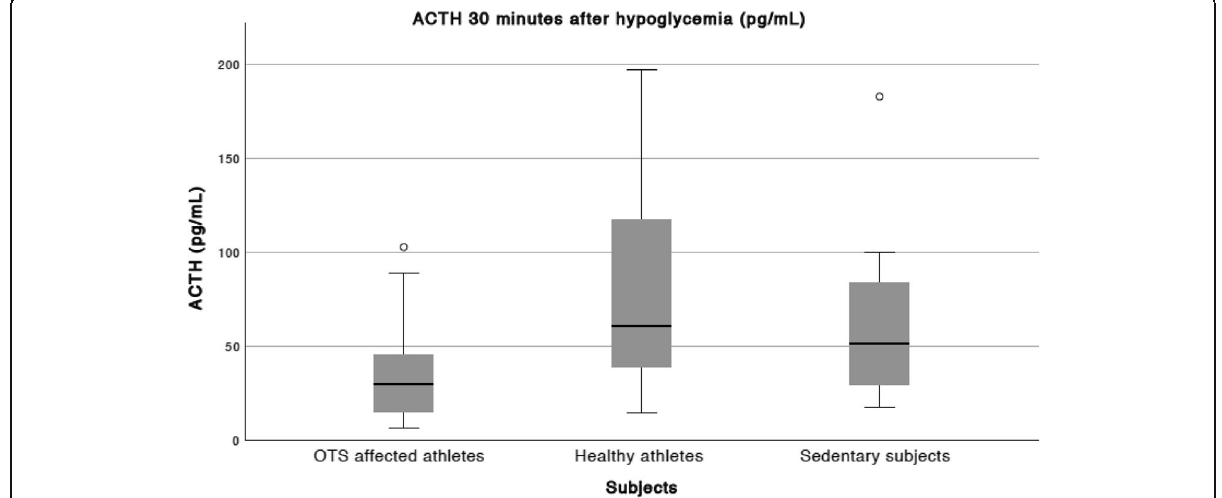
Fig. 3 Median and CI (P5-P95) plasma ACTH 30 min after hypoglycemia, in response to an